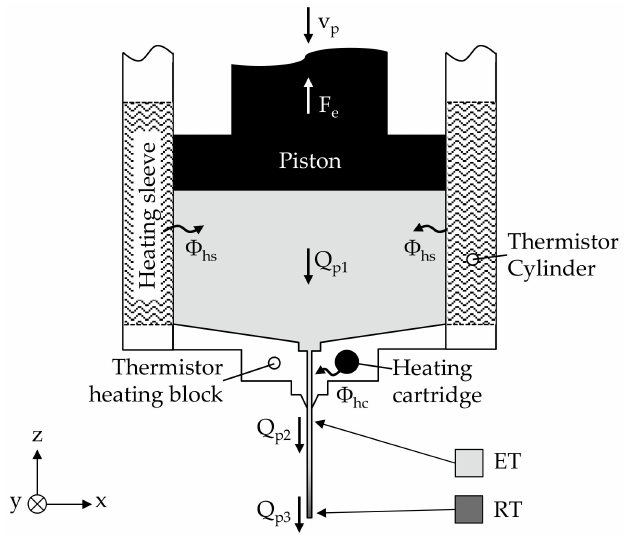
Figure 3. Extrusion model for piston-based material